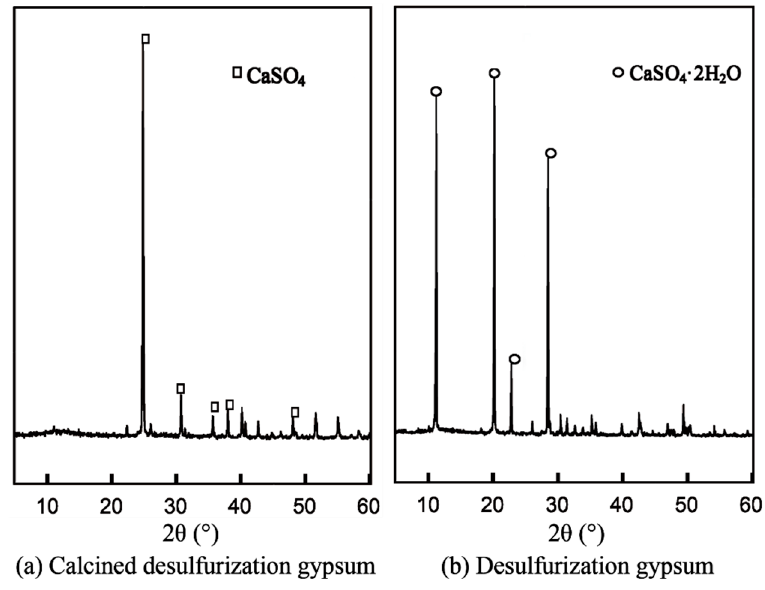
Figure 2. XRD of FGD gypsum.